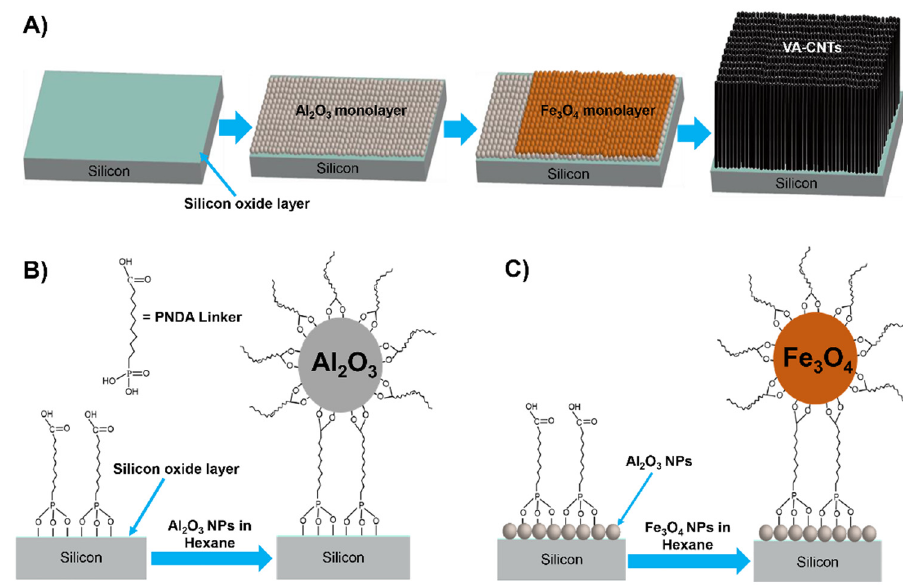
Figure 1. Schematic illustration of catalyst support and catalyst nanoparticle monolayer film assembly for the synthesis of VA-CNTs. ( A ) Step-wise formation of Al 2 O 3 and Fe 3 O 4 nanoparticle monolayers on a freshly cleaned SiO 2 wafer. Schematic representations of ( B ) Al 2 O 3 and ( C ) Fe 3 O 4 nanoparticle monolayer assembly.